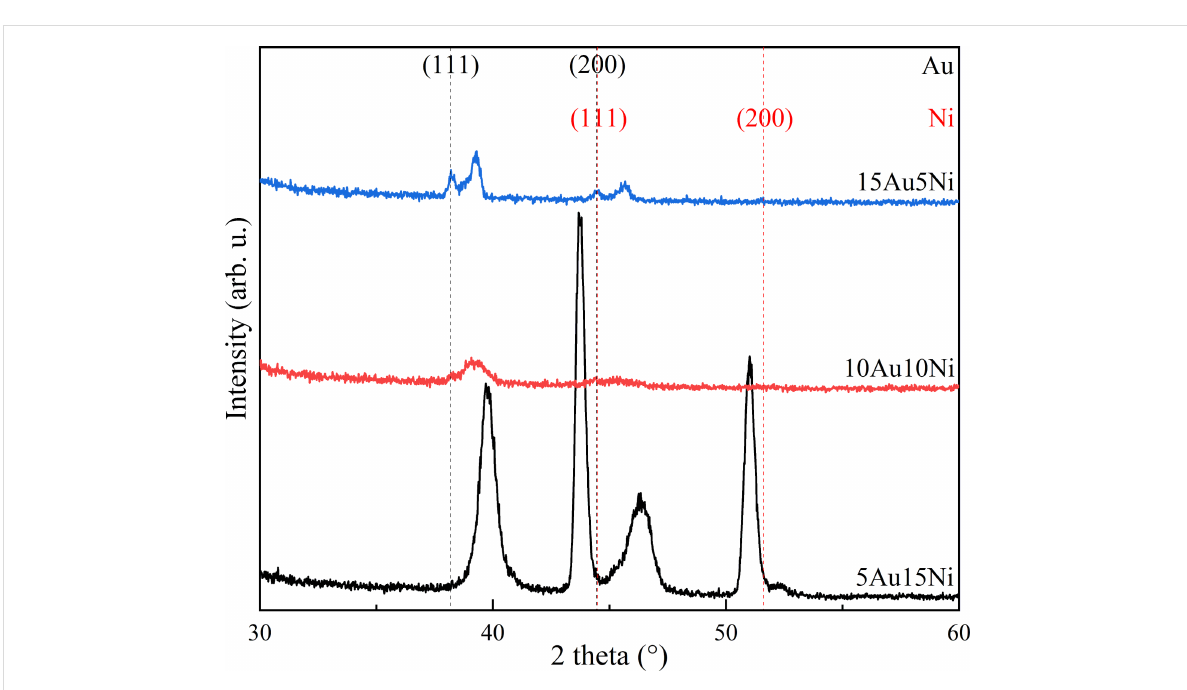
Figure 3: XRD patterns of the dewetted systems after annealing at 1050 °C. The standard data of Au (PDF 03-065-2870) and Ni (PDF 03-065-0380) are